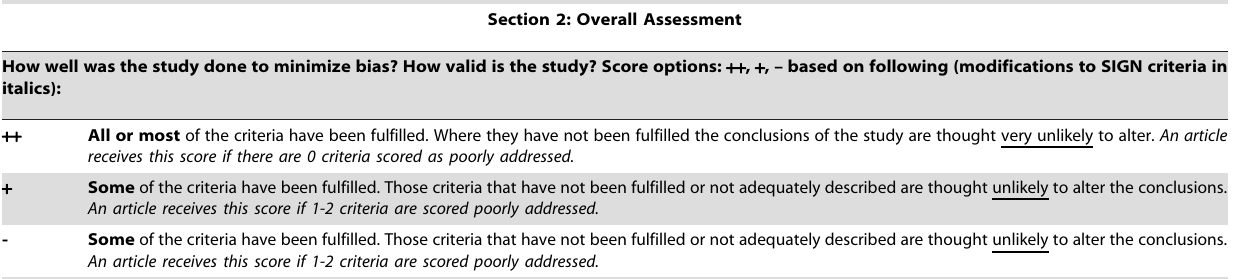
Excel table for each study and formatted in preparation for inclusion in Tables 2–4.